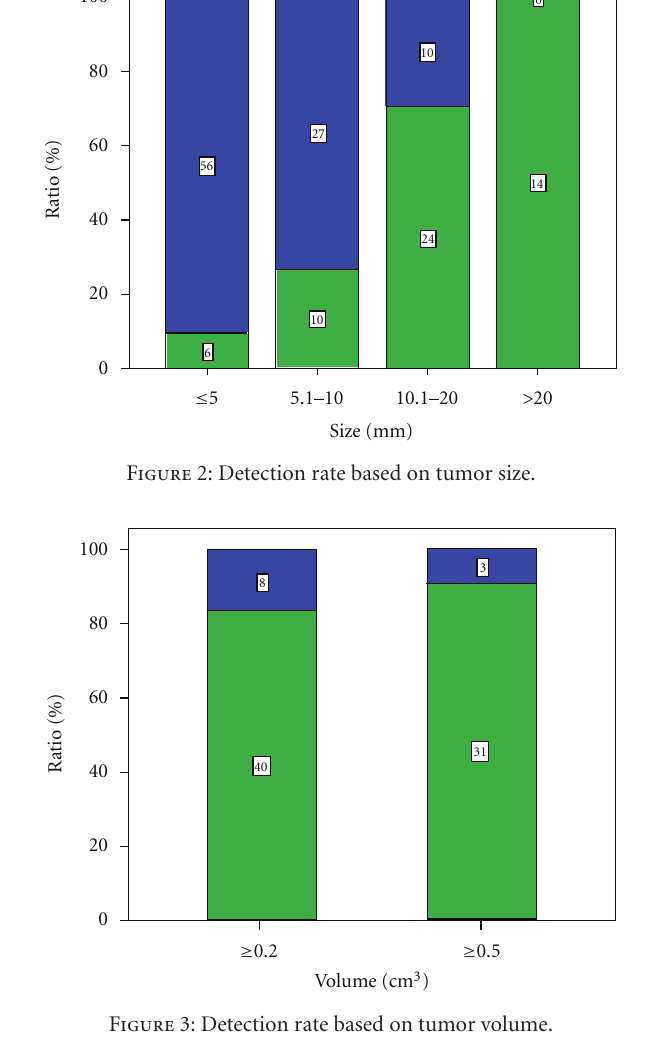
the posterior part, and 14 (9.5%) in both anterior and posterior parts of the prostate. RTE detected a total of 54 cancer lesions out of the 147 (36.7%). The median volume when only including tumors ≥ 0.2 cm 3 was 0.85 cm 3 (range: